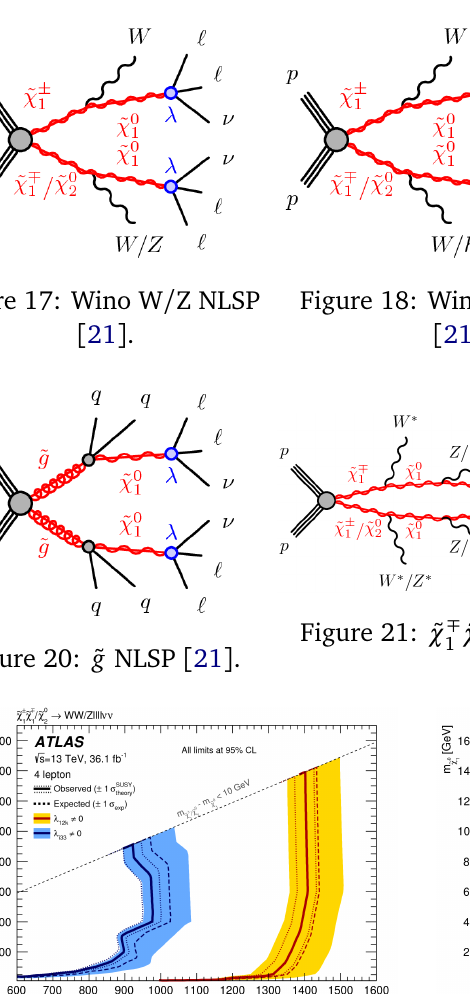
Figure 18: Wino W / h NLSP